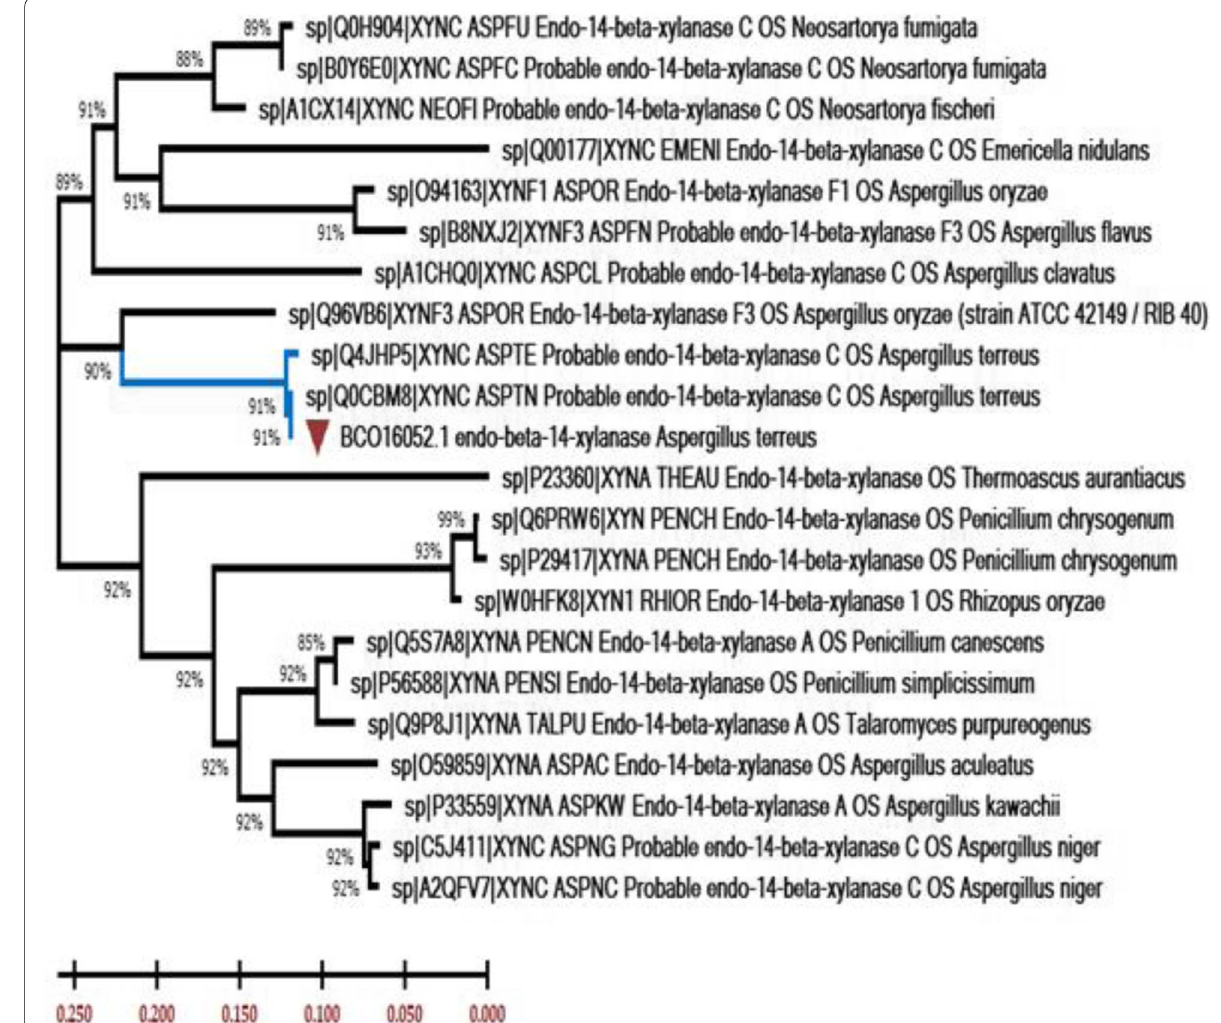
Fig. 20 Phylogenetic tree of xylanase proteins from A. terreus strain RGS. Eg‑NRC was inferred using the neighbor‑joining method (MEGA